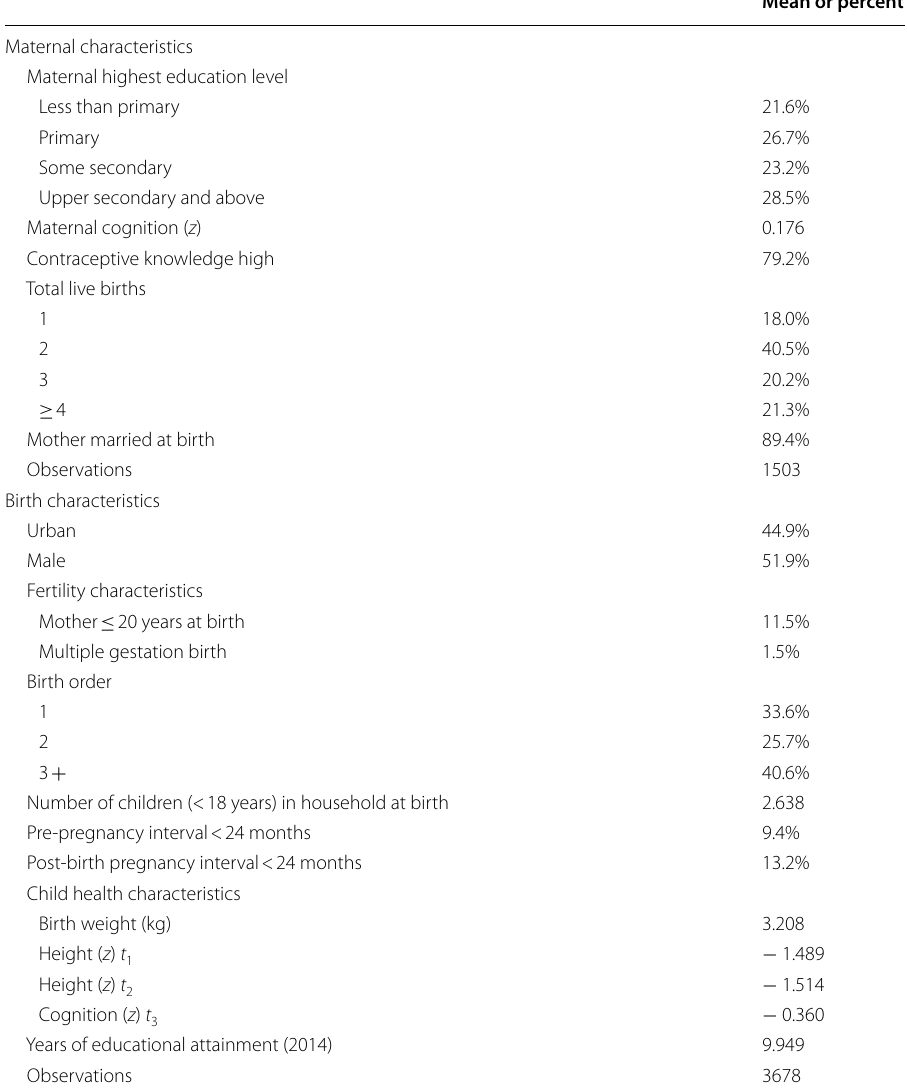
Source: Indonesian Family Life Survey Waves